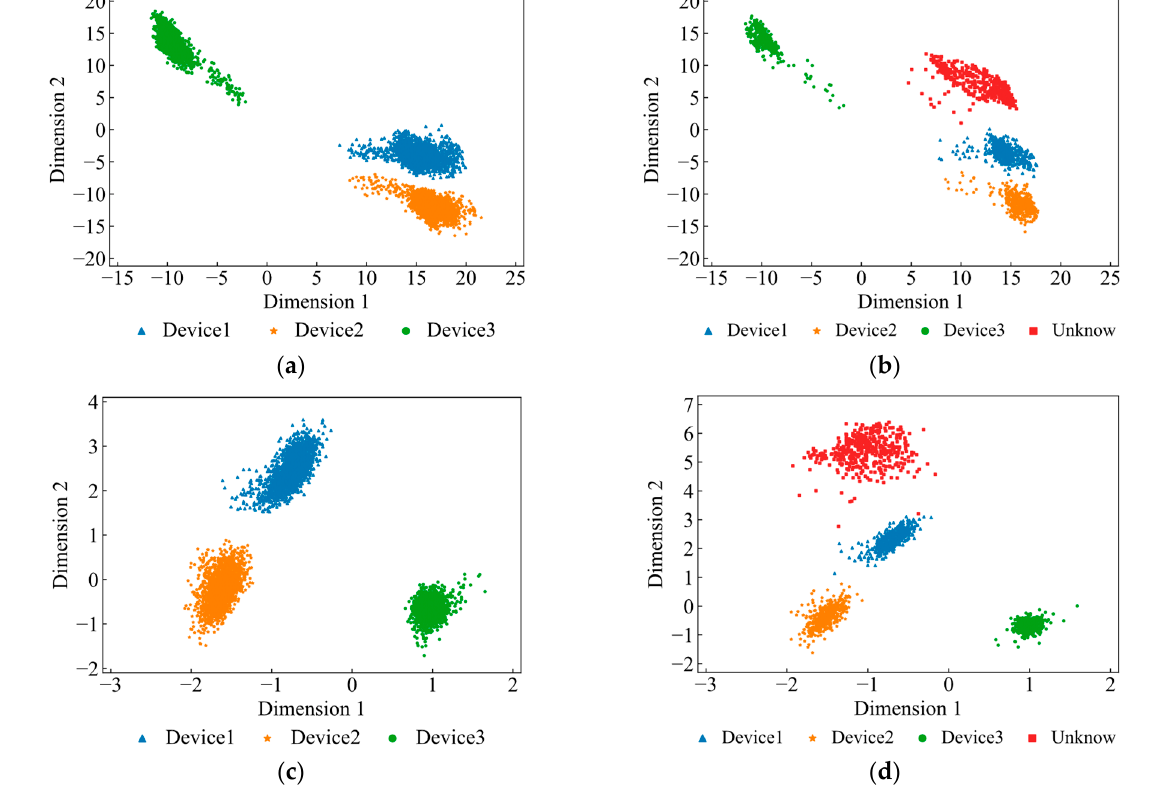
Figure 6. Feature distribution under different values of λ : ( a ) training features when λ was 0; ( b ) testing features when λ was 0; ( c ) training features when λ was 0.005; ( d ) testing features when λ was 0.005.